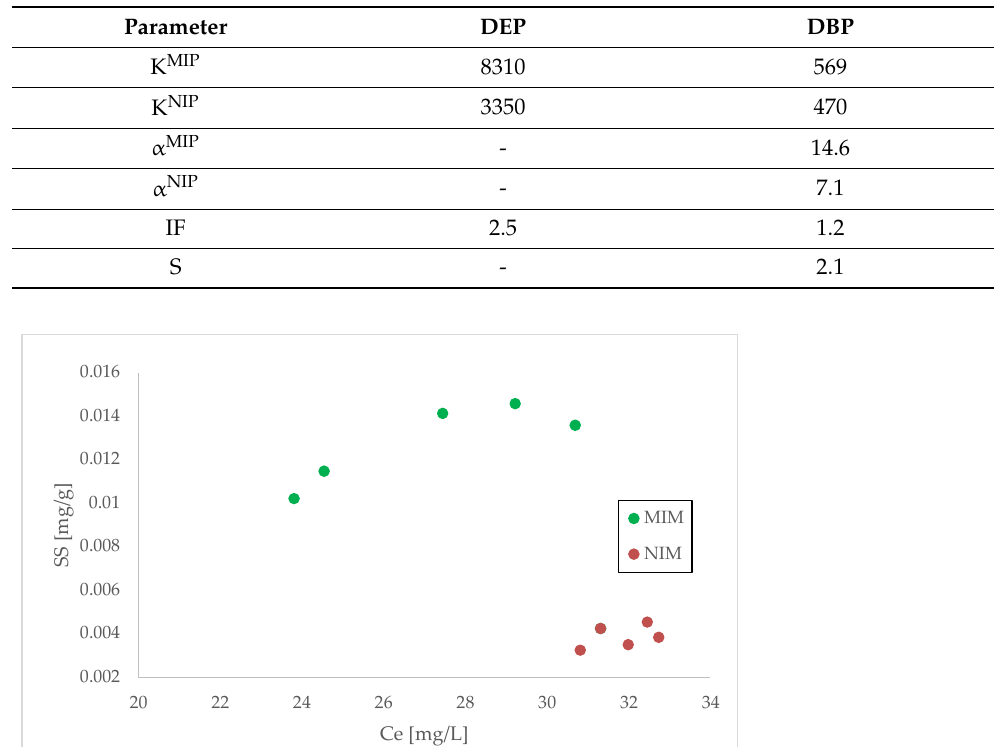
Table 6. Selectivity results for molecularly imprinted membrane (MIM) and non-imprinted membrane (NIM) membrane.